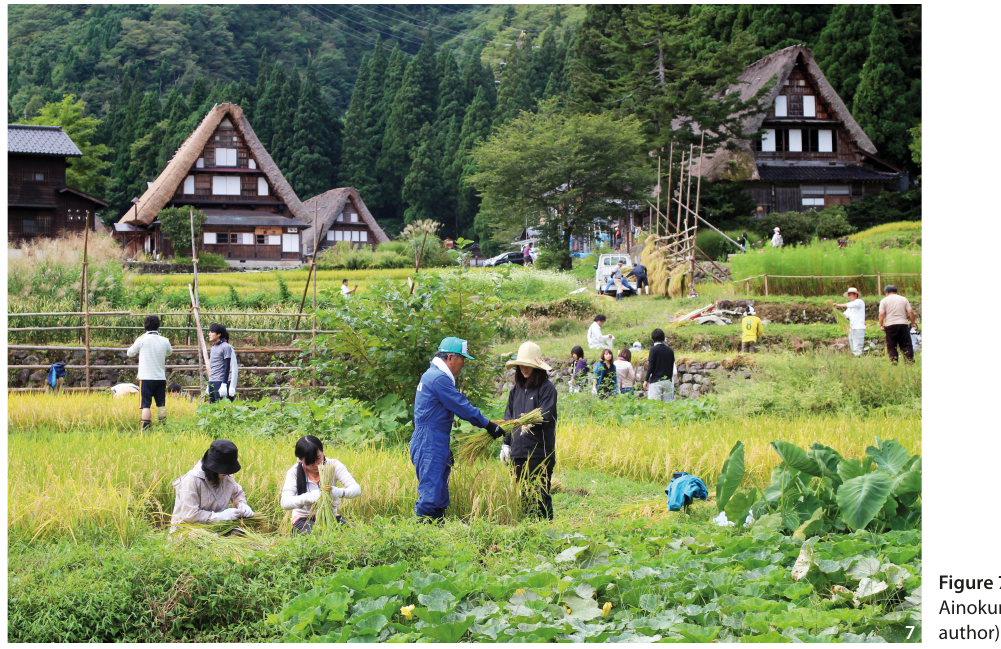
Figure 7 Harvest event in Ainokura village (Source: the author).